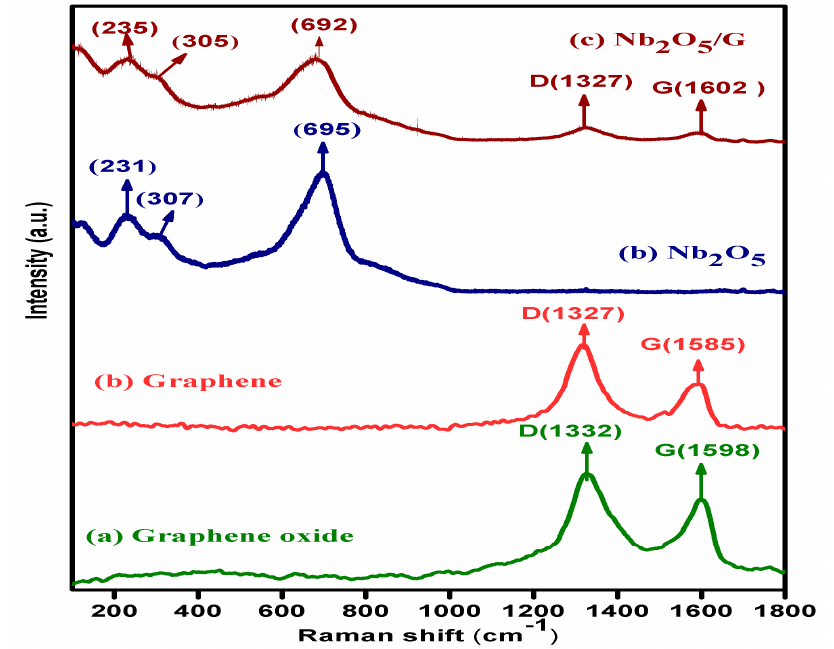
Figure 5. Raman spectra of ( a ) graphene oxide ( b ) graphene, ( c ) Nb 2 O 5 , ( d ) Nb 2 O 5 / G composite.